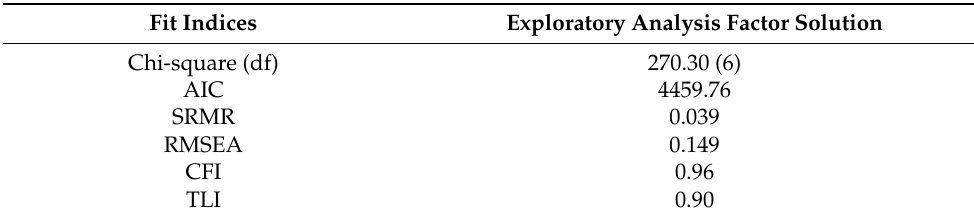
Table 4. Confirmatory factor analysis of the International Physical Activity Questionnaire short form